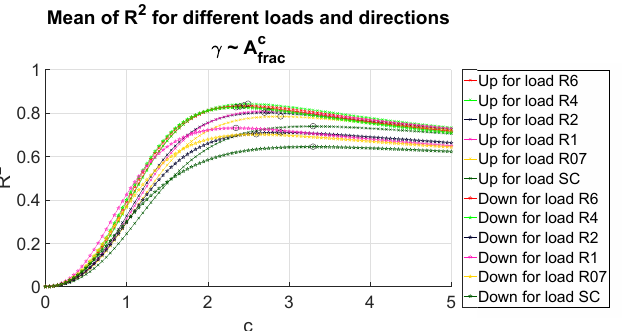
Figure 14. Mean of the coefficient of determination R 2 for different values of c for different loads and directions for the linear regression of γ el ∼ A c when the intercept is set to zero. In the legend, frac NL stands for No Load; R6 stands for load 6.6 Ω ; R4 stands for load 4.4 Ω ; R2 stands for load 2.2 Ω ;